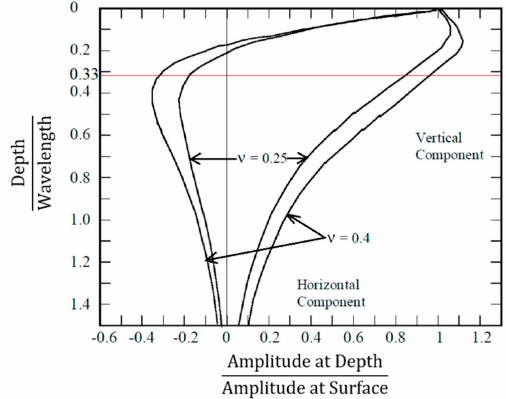
Figure 1. Variation of Rayleigh wave particle motion with depth for a half-space with different values of Poisson’s ratio, v